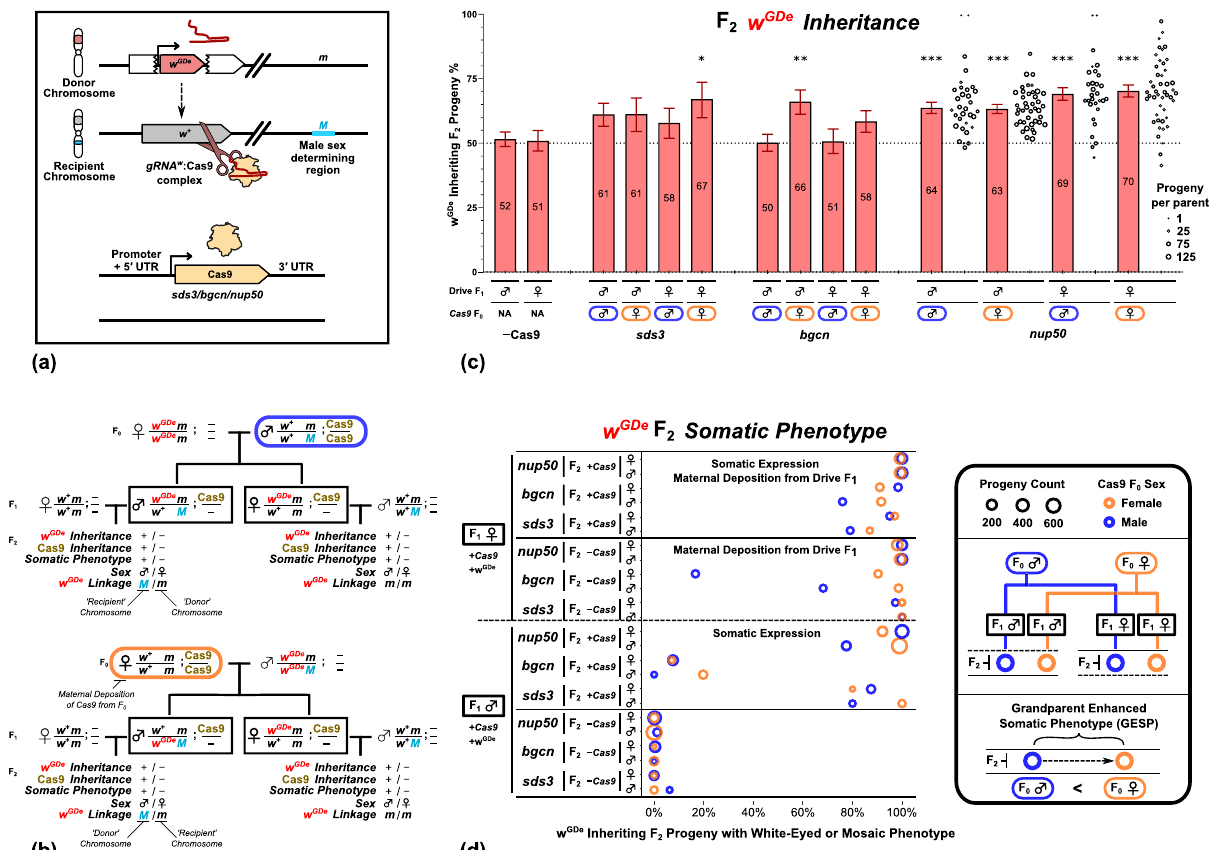
Fig.1|Genedriveelement( w GDe )inheritanceandsomaticeyephenotypeinthe progeny of double heterozygote split drive carriers. a Illustration of gRNA:Cas9 split drive system. The gene drive element GDe is inserted into, and disrupts,the white genewhichistightlylinked tothesex-determiningregion( M or m ). b Breeding schemes for the fourcrossesper Cas9 expressionvariant. The solid boxes indicate the F 1 genotypes that may bias the inheritance of w GDe in their germline. The upper family tree shows the double heterozygous F 1 with paternally